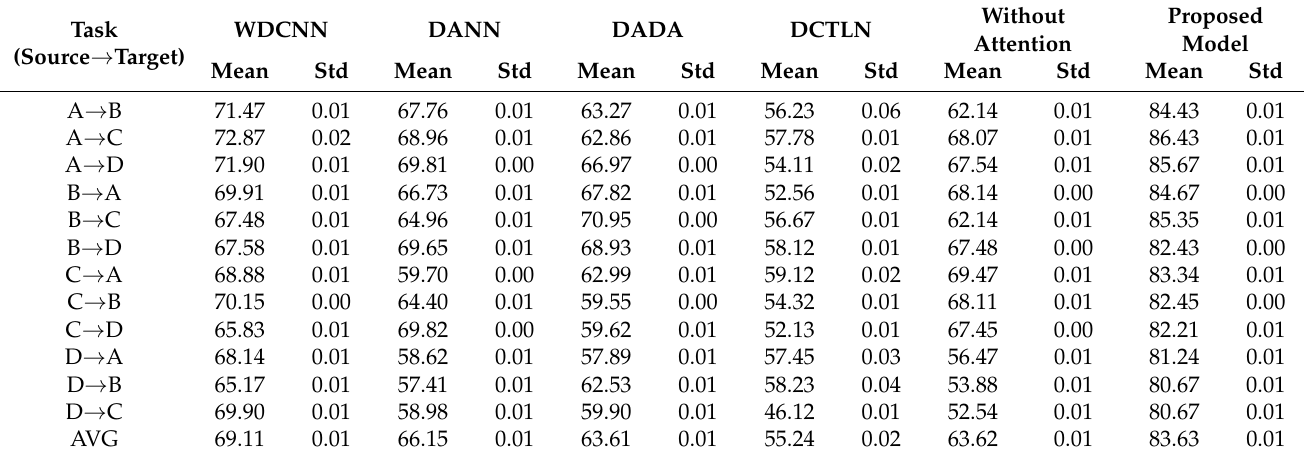
Table 6. The comparison accuracy of the classification results with three new working condition domains on the CWRU dataset.